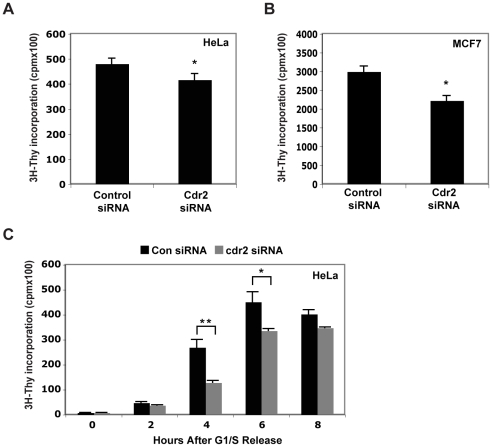
Cdr2 knockdown causes impaired proliferation.Steady state proliferation (3H-thymidine incorporation (cpm)) of HeLa (A) and MCF7 (B) cells after control or cdr2 siRNA treatment. *p<0.05. C. HeLa 3H-thymidine incorporation (cpm) time course in cells released from G1/S block; *p<0.05, **p<0.005.